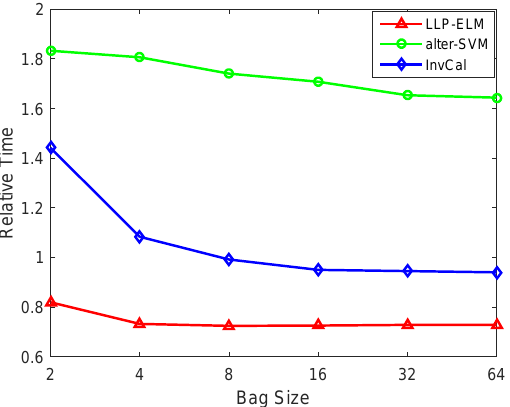
Figure 8. The training time of different methods on Caltech-101. Specifically, the x-axis is bag size and y-axis represents relative time of different